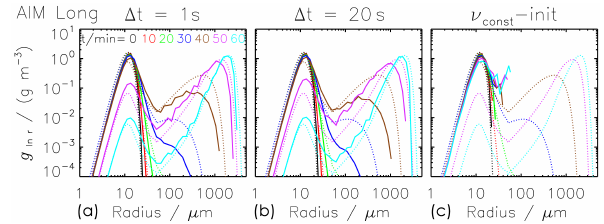
Figure 11. Mass density distributions obtained by AIM for the Long kernel from t 0 to 60min every 10min (from black to cyan; see = legend). The dotted curves show the reference solution; the solid curves show the AIM simulation results (ensemble averages over 50 realisations). The default settings are probabilistic singleSIP-init with weak threshold η 10 − 9 , κ 40, (cid:49)t 1s (left panel); (cid:49)t = = = increased to 20s (middle panel); ν const -init technique with N SIP = 160 (right panel). Figure 12. Moments λ 0 and λ 2 as a function of time obtained by AIM for the Long kernel. The black diamonds show the ref- erence solution. The curves depict the AIM results (averages over 50 realisations). The default settings are probabilistic singleSIP-init with weak threshold η 10 − 9 , κ 40 and (cid:49)t 10s. The left col- = = = umn shows a variation of (cid:49)t (see legend) and the middle column a variation of κ (see legend). The right column displays simula- tions with various initialisation techniques: the ν const -init (solid) and ν draw -init (dotted) with various N SIP values (see legend) as well as the ν random , rs -init (green dashed) and ν random , lb -init (green dash-